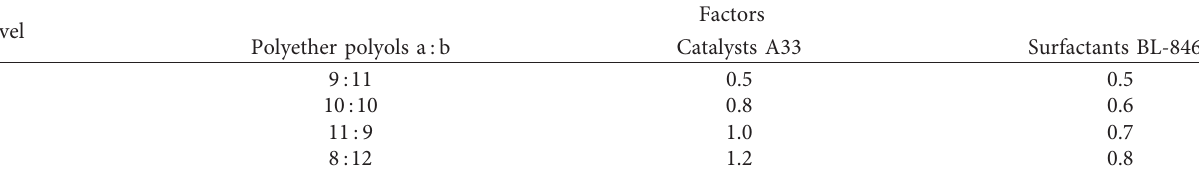
Table 1: Orthogonal test scheme of three factors and four levels (L16).